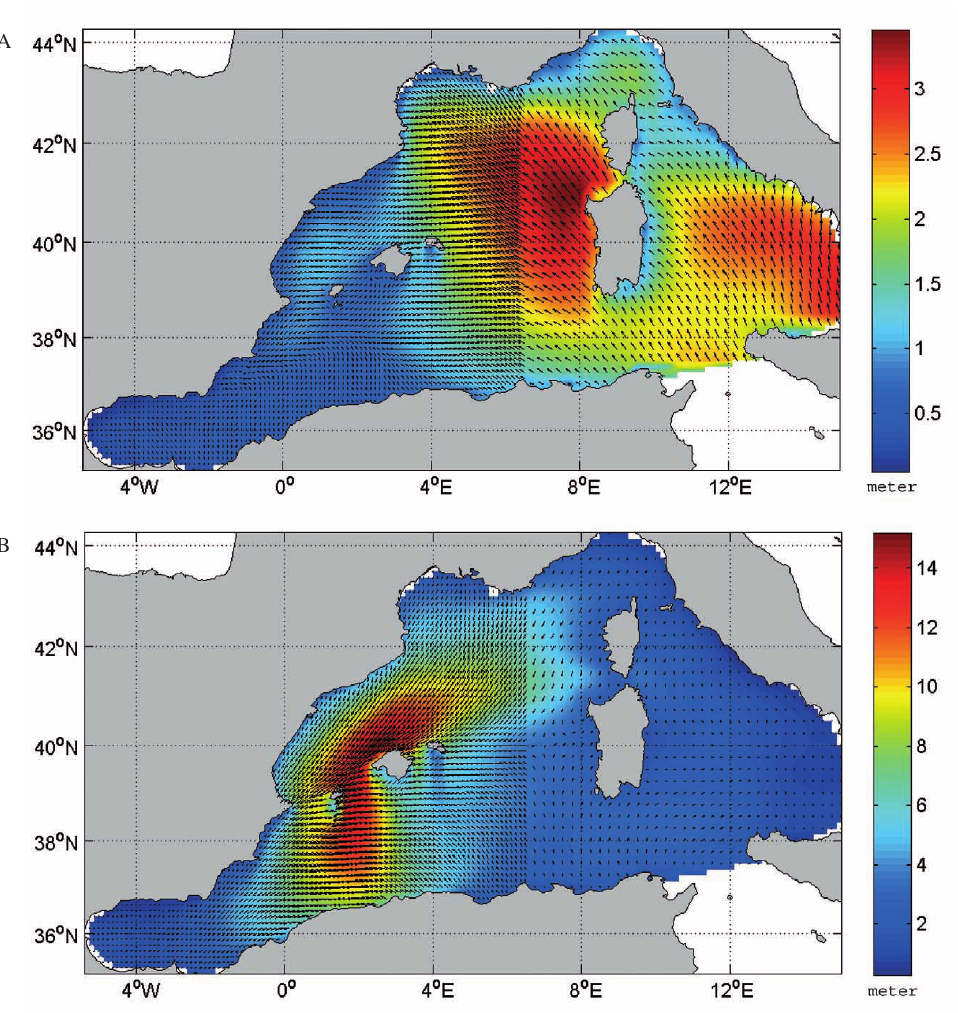
Fig . 10. – a, snapshot from the HiPoCas database (12/01/2001), which shows the sWH field associated with the south-west winds generated near the island of Corsica and propagated towards the Gulf of lions. B, snapshot from the HiPoCas database (12/28/1980), which shows the fetch associated with the severe north-east winds, generated in the Gulf of Genoa and propagated towards the Catalonian coast, valencia coast and the